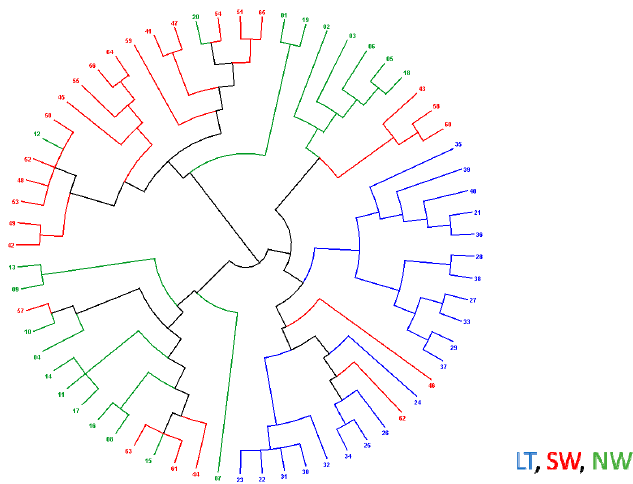
Figure 1. Radial dendrogram presenting subclusters with all individuals. Numbers represent individuals from the LT (blue), the SW (red), and the NW (green) Regions, respectively. with the first three axes explaining about 33% of the genetic variations (axis one 16.80%, axis two 8.44%, and axis three 7.79%) (Figure 2). Numbers represent individuals from the LT (blue diamonds), the SW (red triangles), and the NW (green dots) sampling regions.